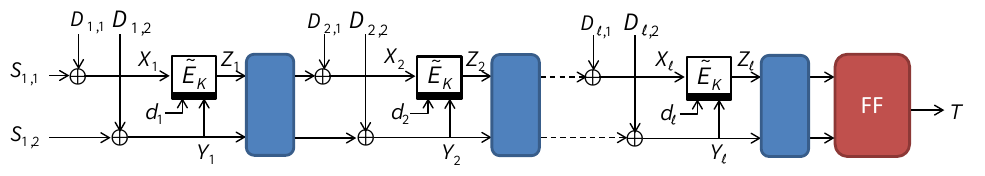
Figure 2: Tag Generation Function TagGen [ e E K